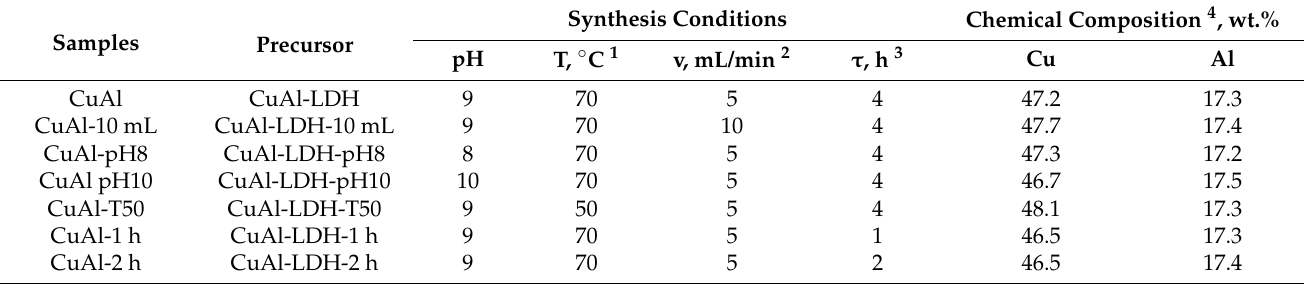
Table 1. The list of CuAl catalysts and CuAl-LDH materials prepared at different synthesis